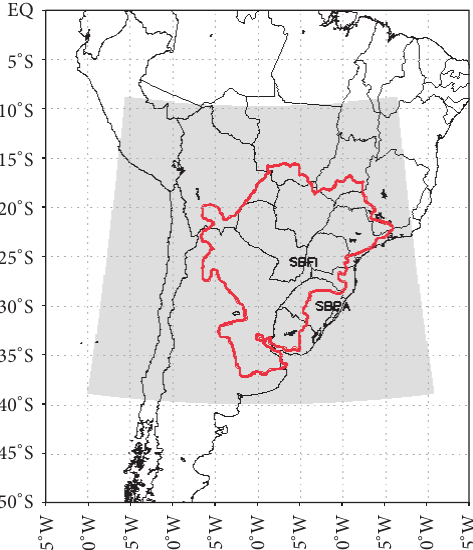
Figure 1: Geographic extent of the La Plata Basin (red contour) and the model domain utilized in the ARW-WRF simulations (grey shading). Four-letter codes indicate the location of Foz do Iguac¸u (SBFI) and Porto Alegre (SBPA) upper air meteorological stations.